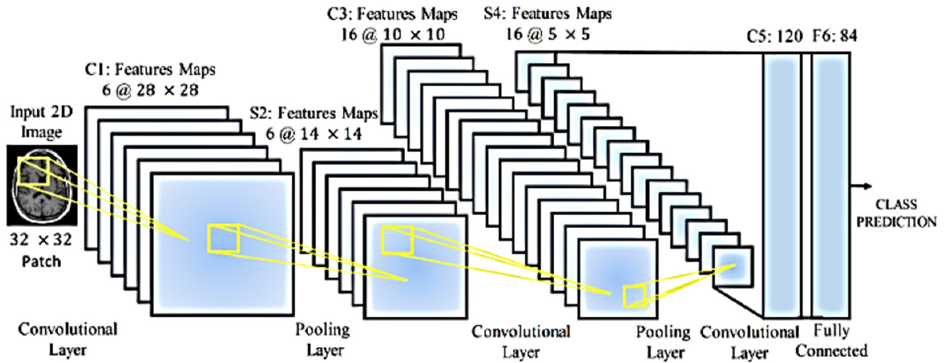
Figure 6. The general architecture of a CNN